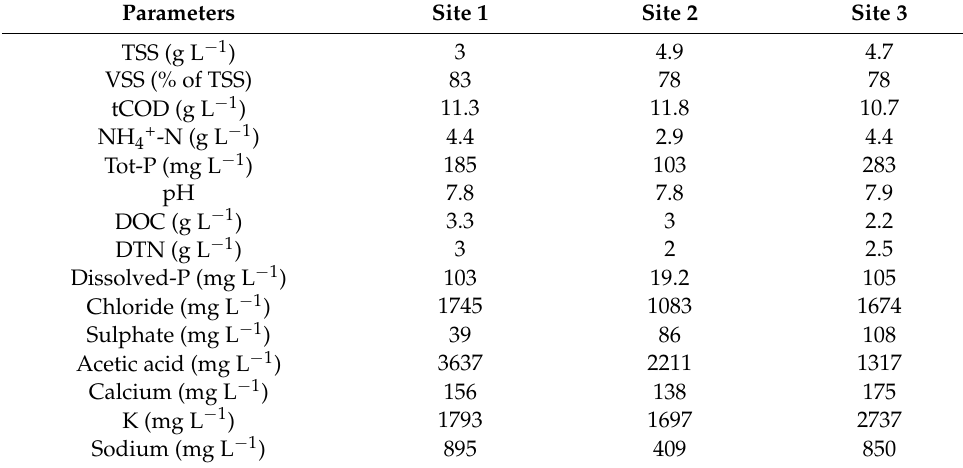
Table 2. Pig manure